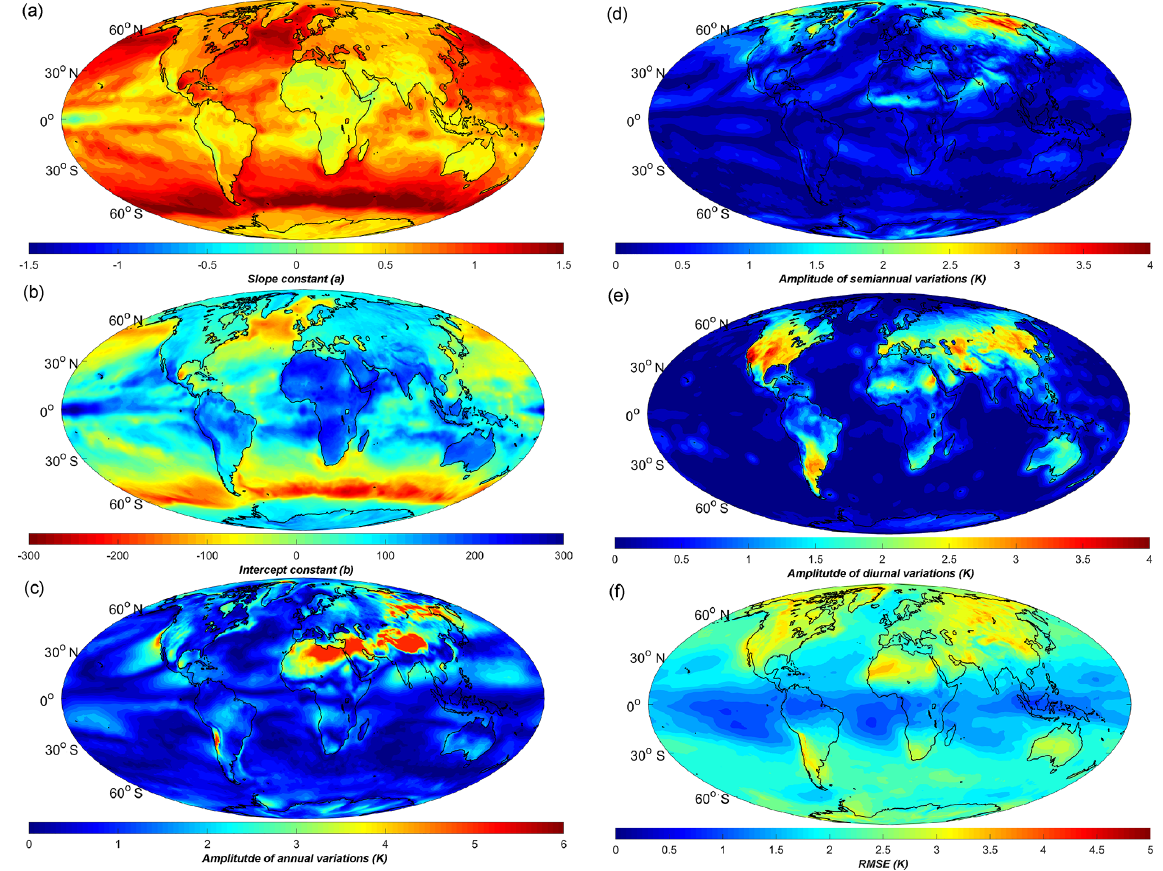
Figure 5. (a) The slope constant a , (b) intercept constant b , amplitudes of T m (c) annual, (d) semiannual and (e) diurnal terms in our time-varying global gridded T s – T m model, and (f) the model-estimated T m RMSE distribution. Temperature unit is